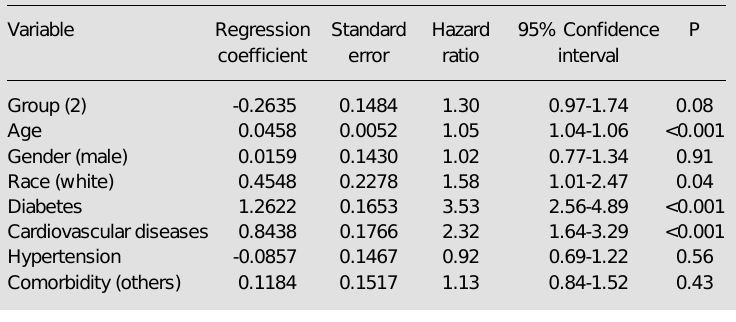
Table 4 - Univariate proportional hazard analysis of variables associated with mortality in dialysis patients. Cox proportinal regression analysis.